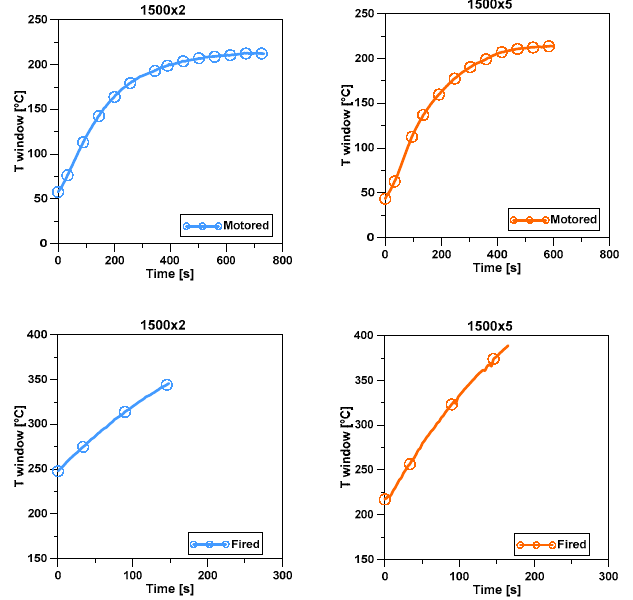
Figure 7. Transient of temperature in motored ( top ) and fired ( bottom ) conditions of the piston, for an engine running at 1500 rpm [17]. Reprinted with permission from Ref. [17] Copyright 2019 SAE International.